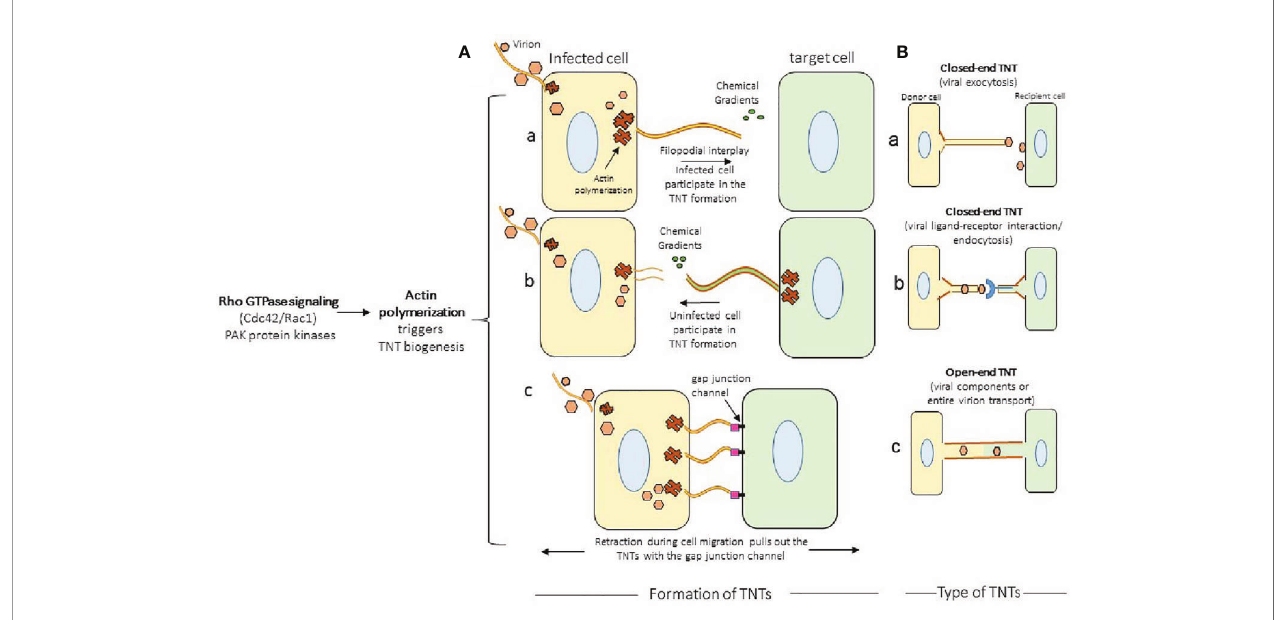
FIGURE 2 | Mechanism of TNTs formation. (A) Actin polymerization together with Rho GTPase signaling leads to the formation of TNT bridges in which either infected cell (pane a; example, herpes simplex virus) or an uninfected cell (panel b; murine leukemia virus) forms the TNTs. The well characterized TNT biogenesis model in HIV and pseudo rabies virus (PRV) demonstrate the transient expression of cell adhesion molecules stabilizes the TNTs. The bridges of TNTs are also formed when the two connected cells retract during their migration resulting the formation of TNTs (panel c). (B ) The types of TNTs. In closed-end TNTs, the cytoplasmic mixing between the donor and the target cells are not achieved, while in the open-end TNTs displays cytoplasmic continuity. Both type of TNTs aid in the viral spread, but it has been suggested that open-ended TNT leads to the generation of multinucleated giant